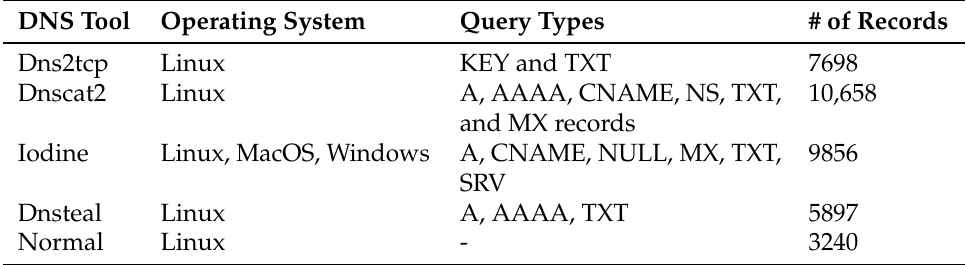
Table 2. DNS tunnel tools’